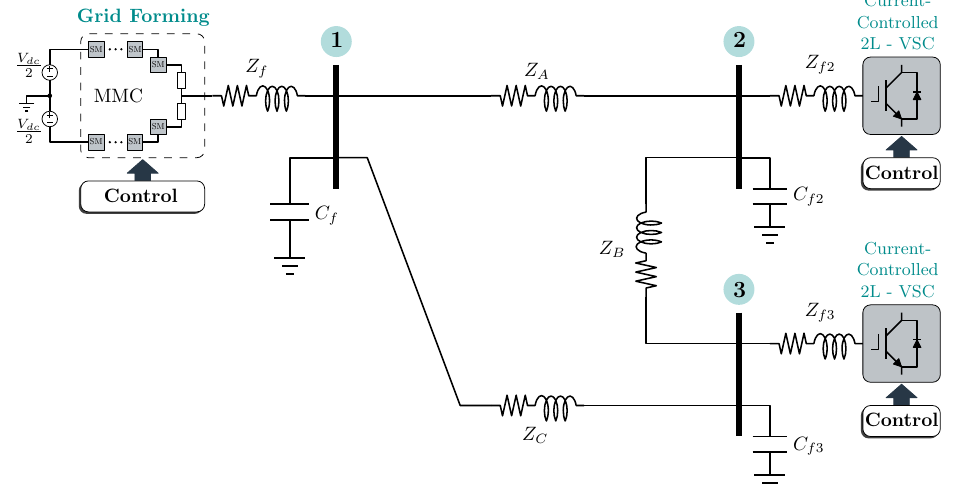
Figure 9. 3-Bus test case for a inverter-populated power